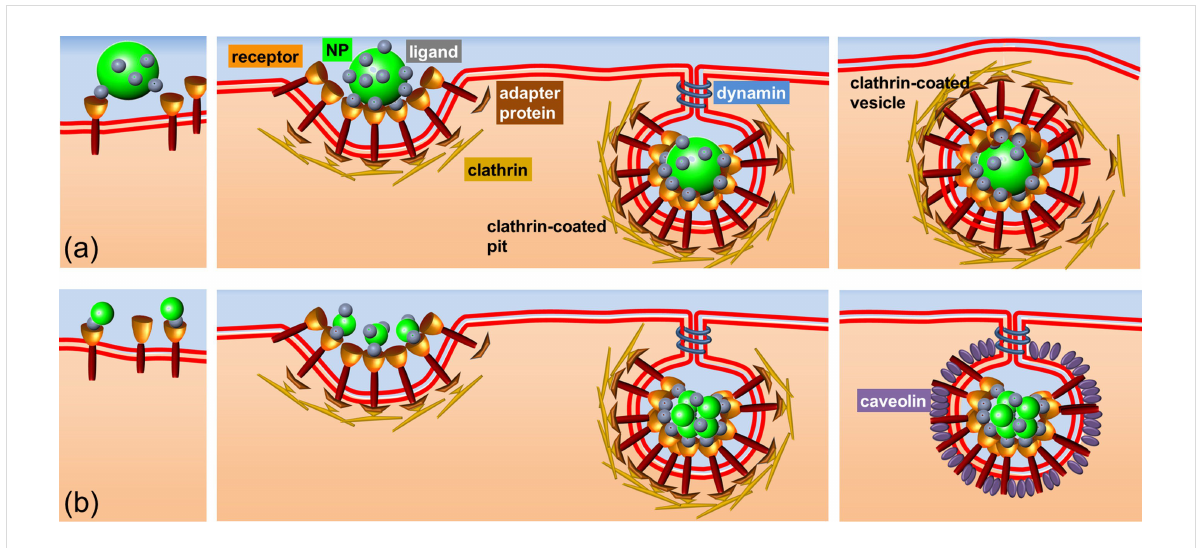
Figure 1: Schematic representation of the cellular uptake of (a) large and (b) small NPs. Whereas larger NPs exert interactions with the cell membrane that are sufficiently strong to trigger internalization of one NP at a time, smaller NPs have to form a cluster of a certain size to induce membrane